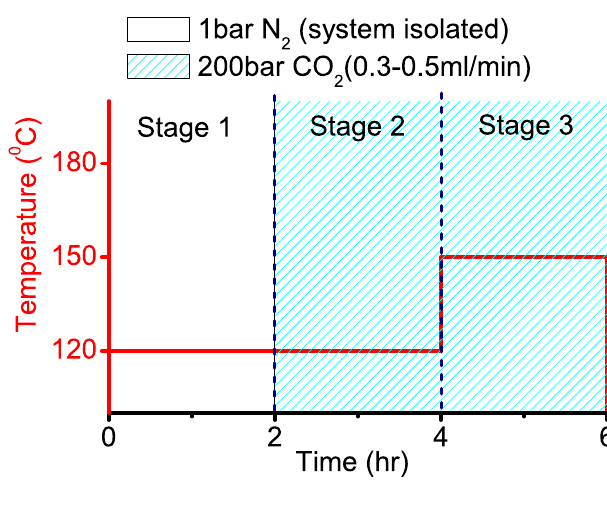
Figure 3. Three stages for the production of sample PC-6 hrs.